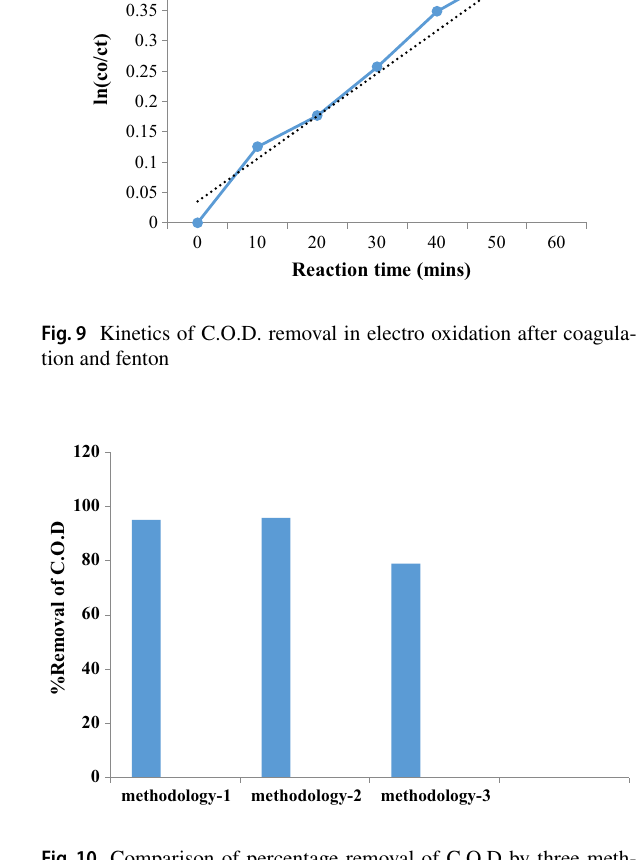
Fig. 10 Comparison of percentage removal of C.O.D by three meth- odologies used in this